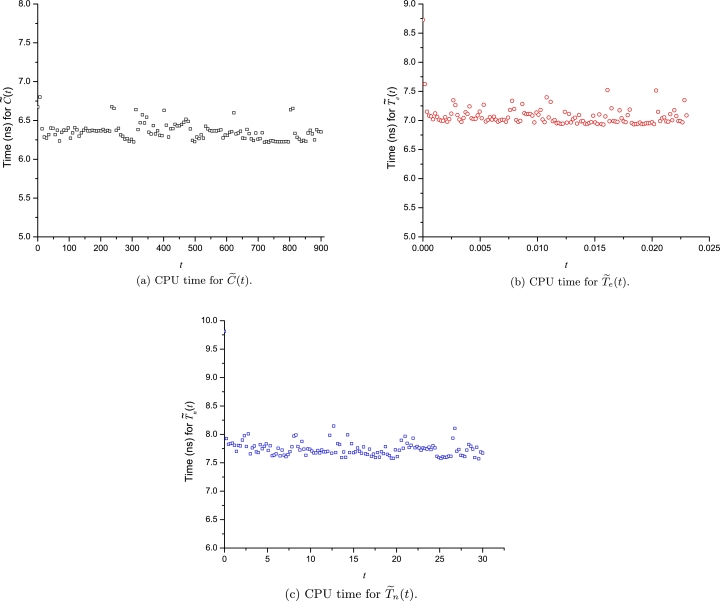
CPU time for LP-approximations of CML.